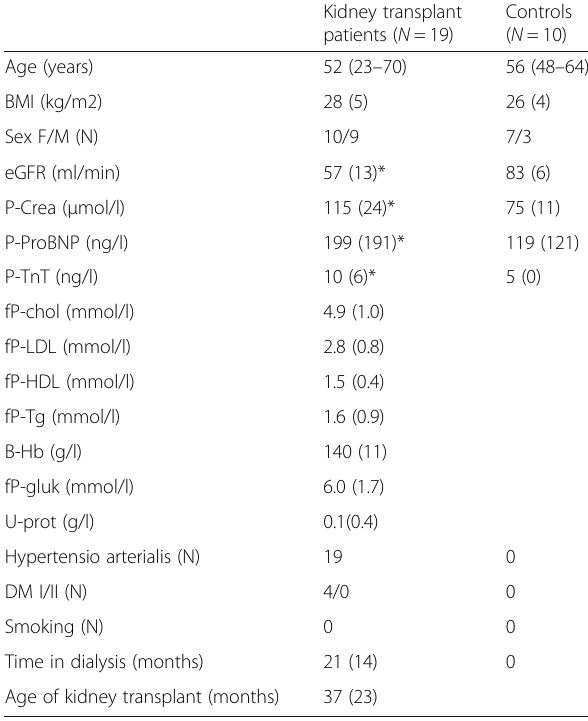
Table 1 Baseline